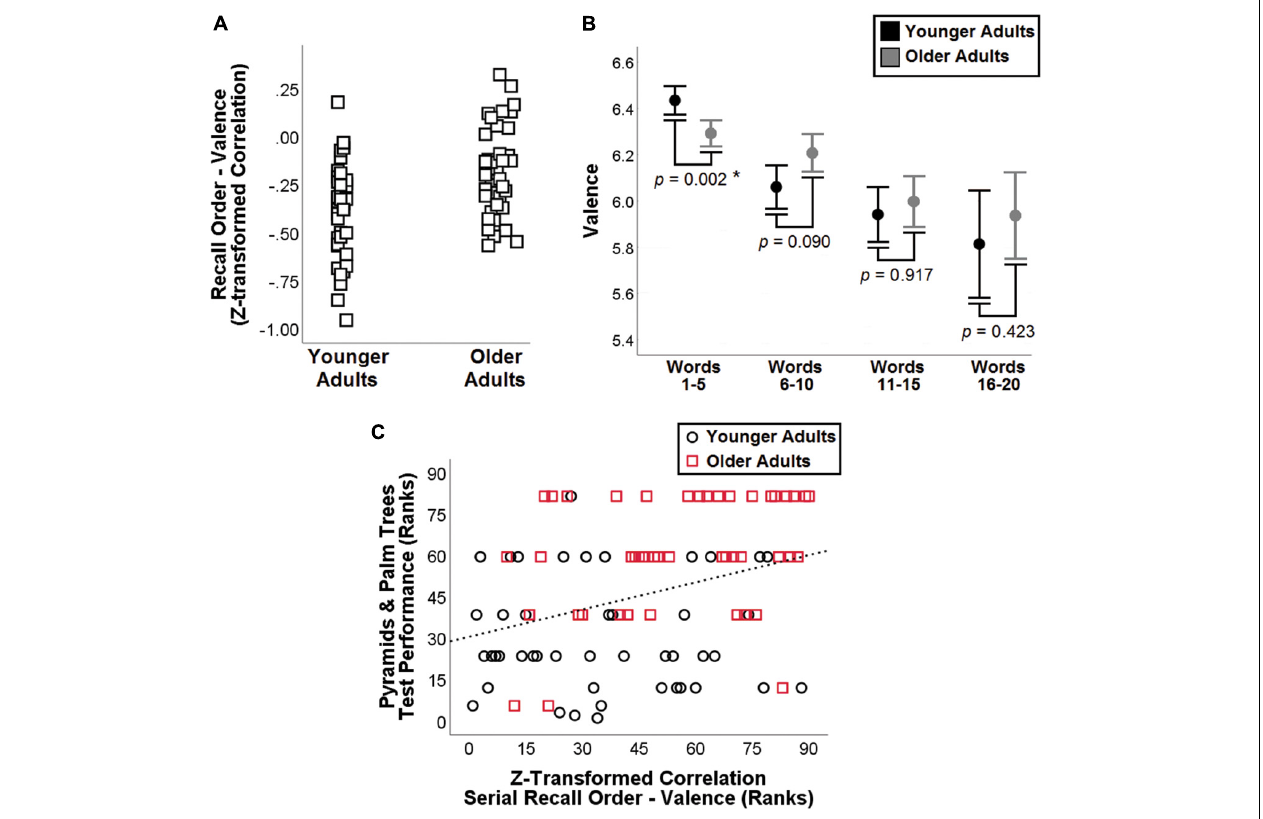
FIGURE 4 | Outcome of feature-to-feature correlation analysis. Group distributions of the z-transformed coefficient of correlation between serial recall order and valence is shown on the left (A) , while post hoc analyses of five-word positions are shown on the right (B) . The association between ranked z-transformed correlation coefficients and performance on the Pyramids and Palm Trees Test is shown below (C)